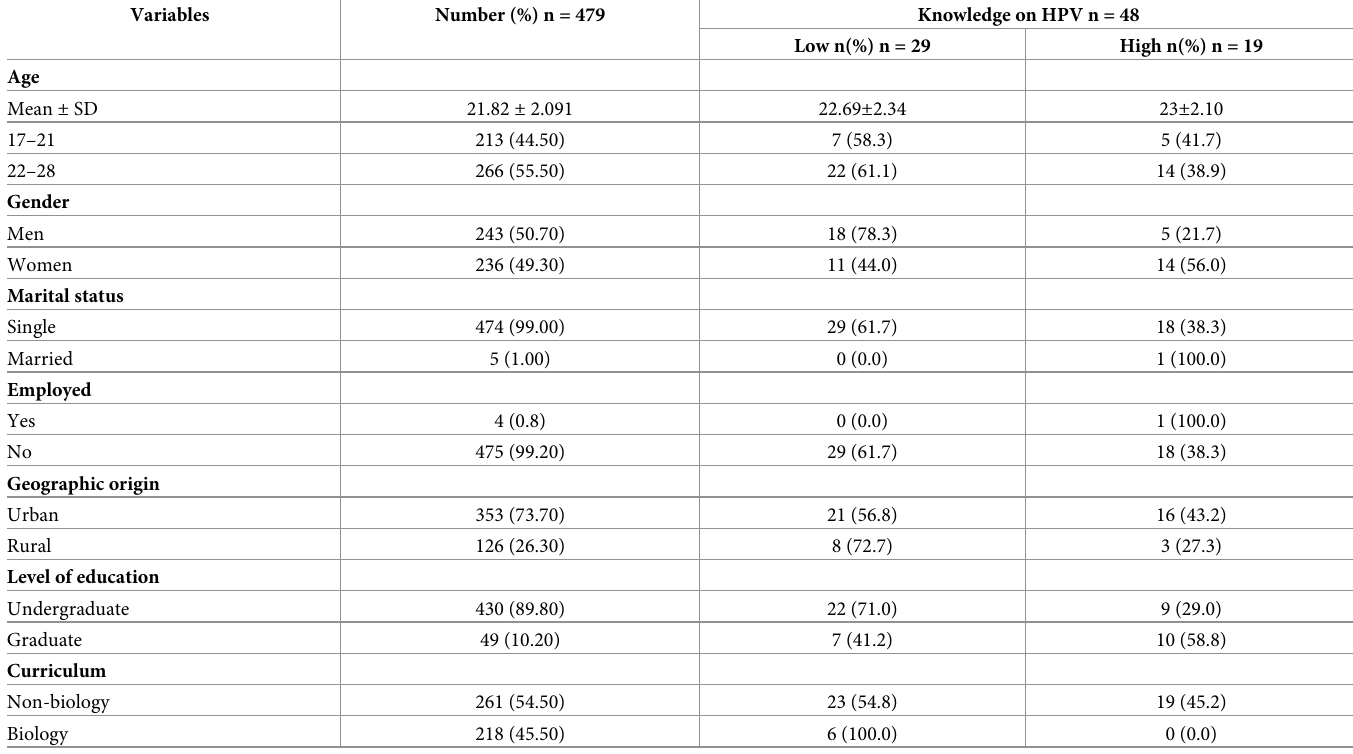
Table 2. Characteristics of the population in correlation with the knowledge related to HPV and cervical